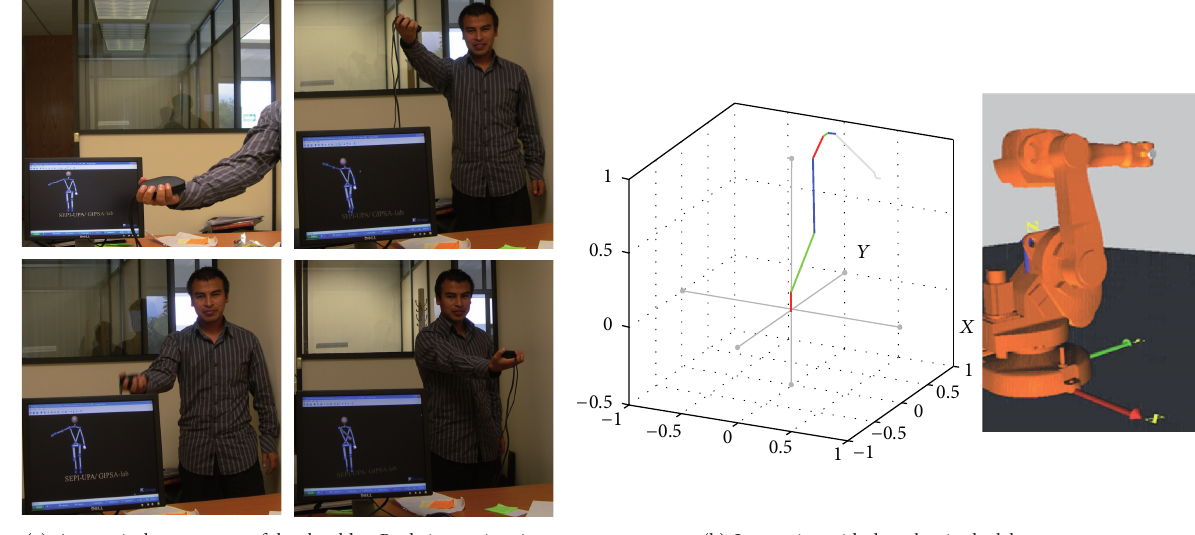
Figure 12: Anatomical movements of the shoulder: real-time